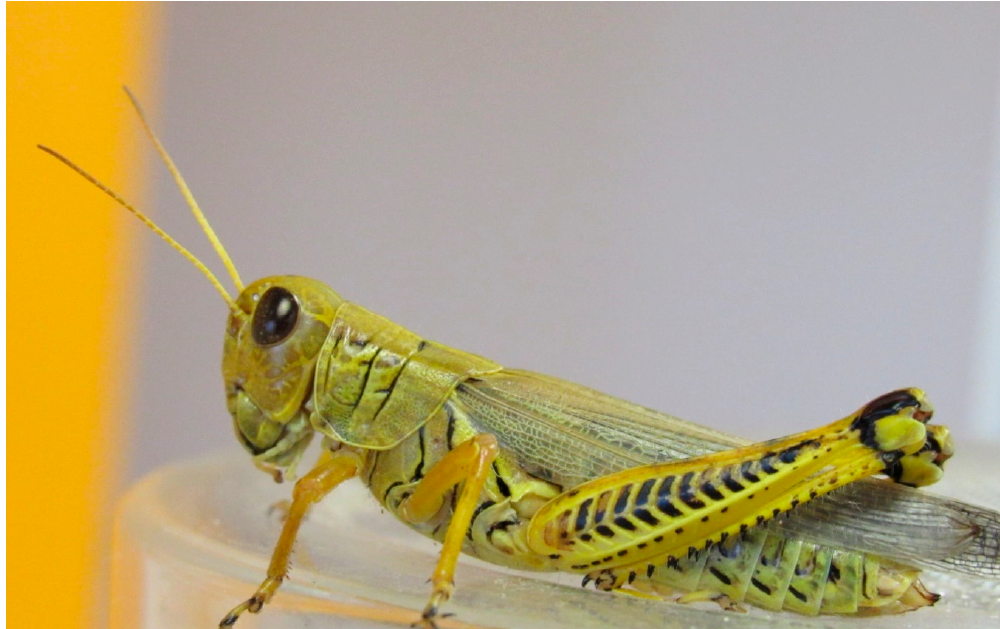
Figure 3. Female Melanoplus differentialis . (Wahid Dakhel, 2014). University of Wyoming, Laramie, WY, USA.